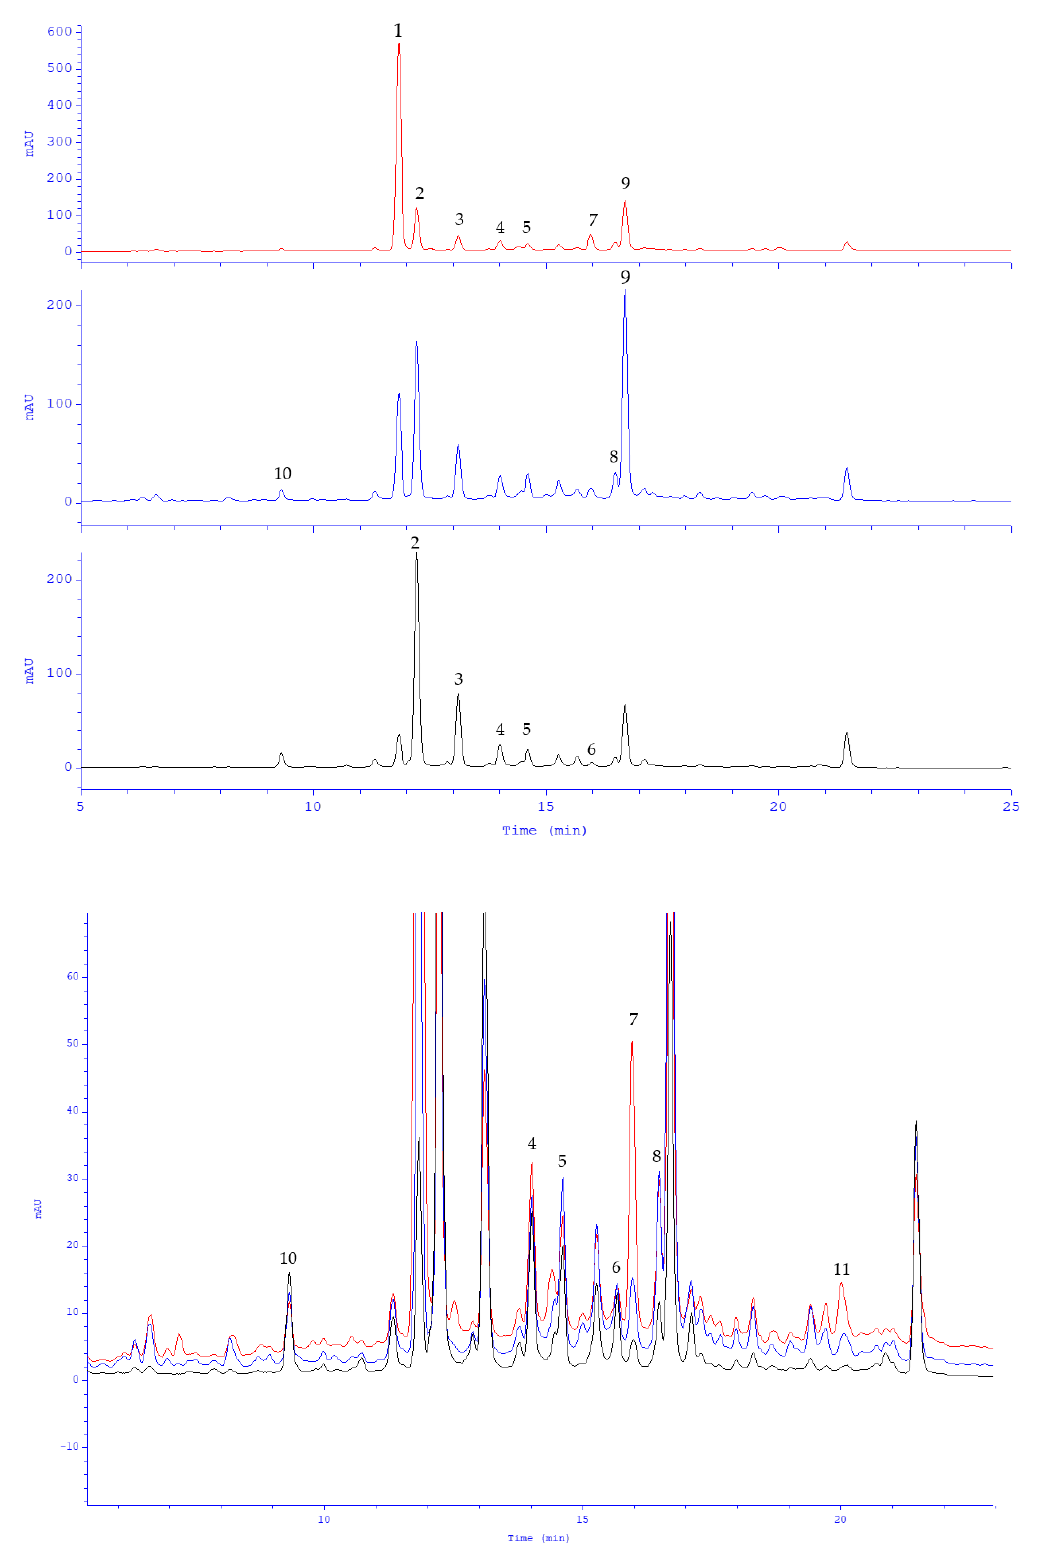
Figure 2. HPLC chromatograms of peppermint leaf dry extract (1.5 mg/mL, 50% aq. methanol); red at 280 nm, blue 320 nm, and black 360 nm. Peak labeling: 1, eriocitrin; 2, luteolin-7- O -rutinoside; 3, luteolin-7- O - β -glucuronoside; 4, narirutin; 5, isorhoifolin; 6, diosmin; 7, hesperidin; 8, lithospermic acid; 9, rosmarinic acid; 10, caffeic acid; 11, eriodictyol.